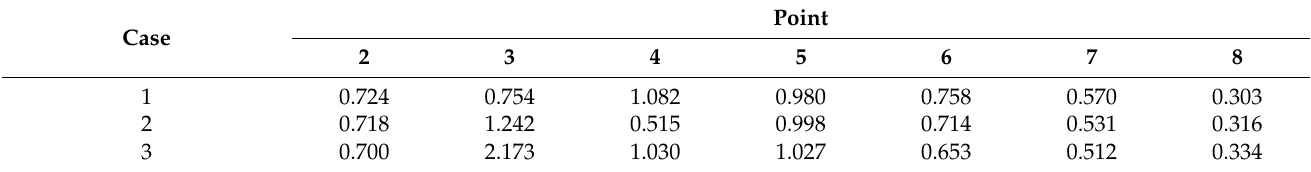
Table 4. Calculation times for the simulation of loading pattern (1) and pattern (2) in three cases.